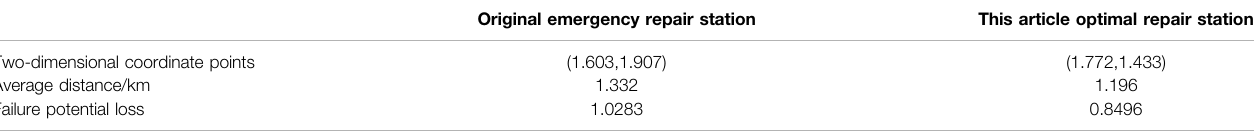
TABLE 3 | Comparison of results before and after optimization.